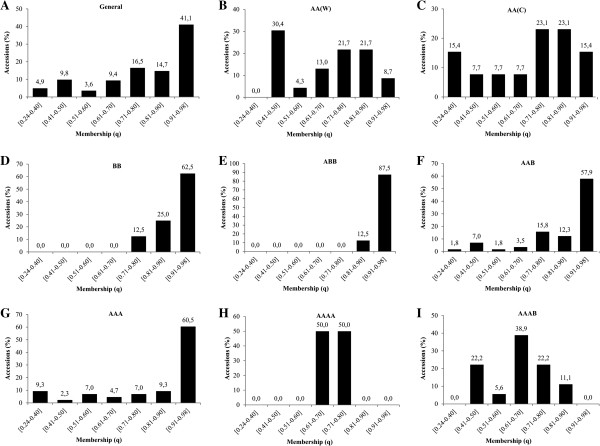
Percent of accessions within intervals of membership (q) for all accessions: A) general; B) wild AA [AA(W)]; C) cultivated AA [AA(C)]; D) BB; E) ABB; F) AAB; G) AAA; H) AAAA; and I) AAAB.